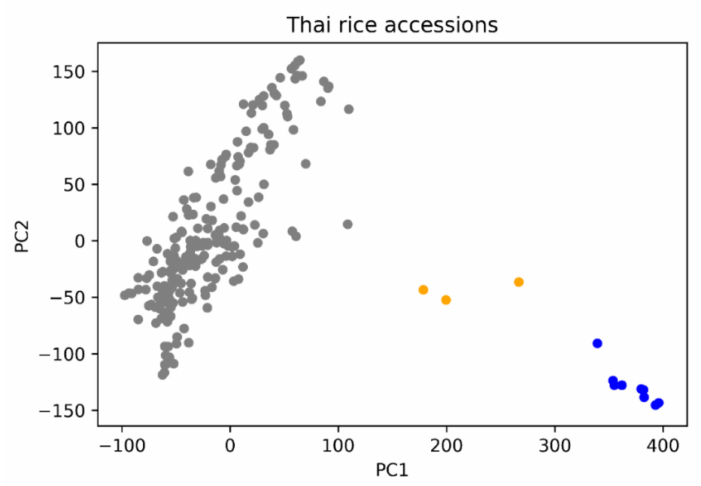
Figure 3. Principal component analysis of 222 accessions from our rice panel. Grey colour (PC1 <= 100) are indica varieties with a handful of japonica (blue) and aus / aro varieties (orange).